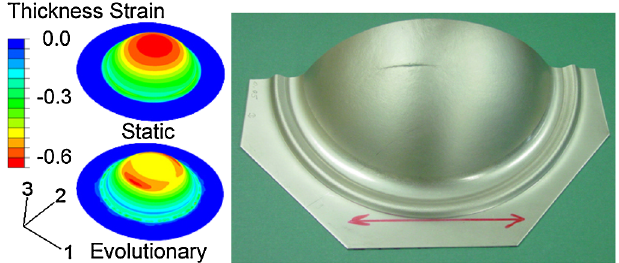
FIG. 12. (Color) Simulations of biaxial bulging using two vari- ants of crystal plasticity finite element models with different assumptions [33,34]; the better one used an evolving yield surface based upon texture